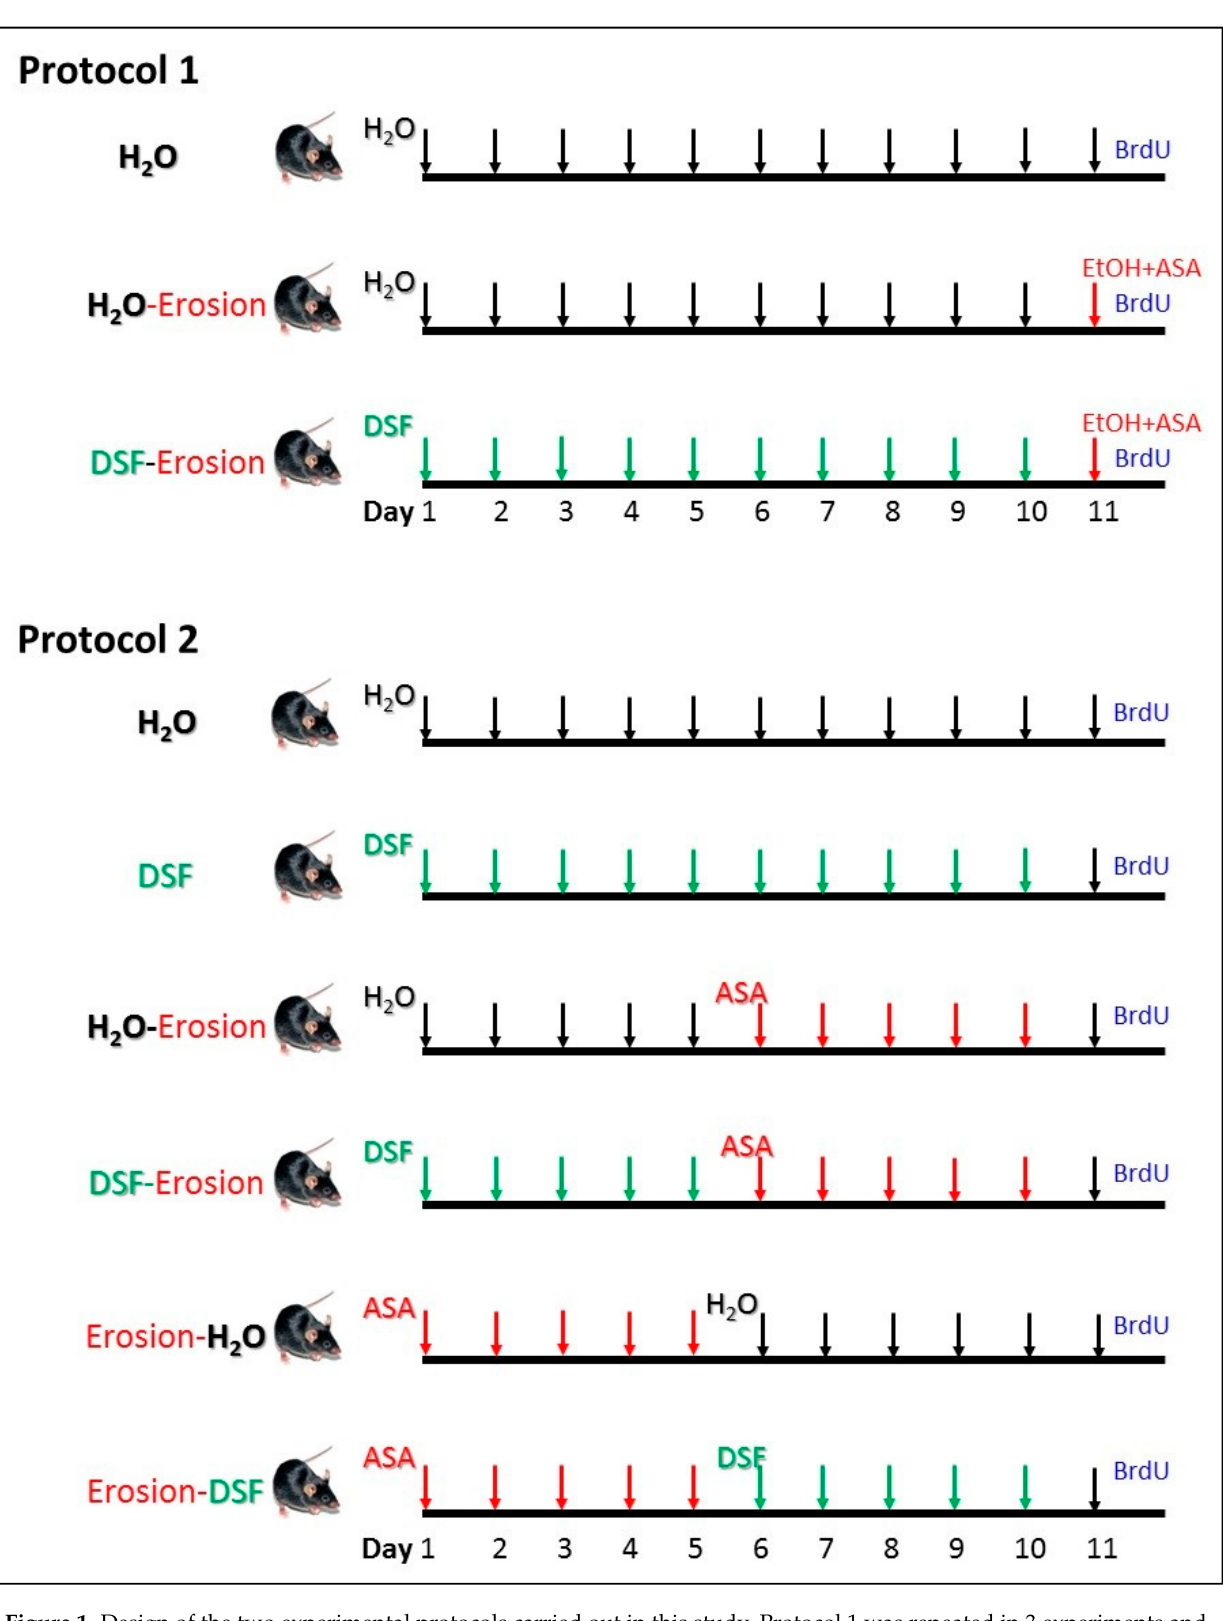
Figure 1. Design of the two experimental protocols carried out in this study. Protocol 1 was repeated in 3 experiments and each time, 3 littermate male mice were used ( n = 9). They were labeled as H 2 O (control), H 2 O-erosion, and DSF-erosion. Protocol 2 was repeated in 5 experiments and each included 6 mice ( n = 30) labeled as H 2 O, DSF, H 2 O-erosion, DSF-erosion, erosion-H 2 O, and erosion-DSF.